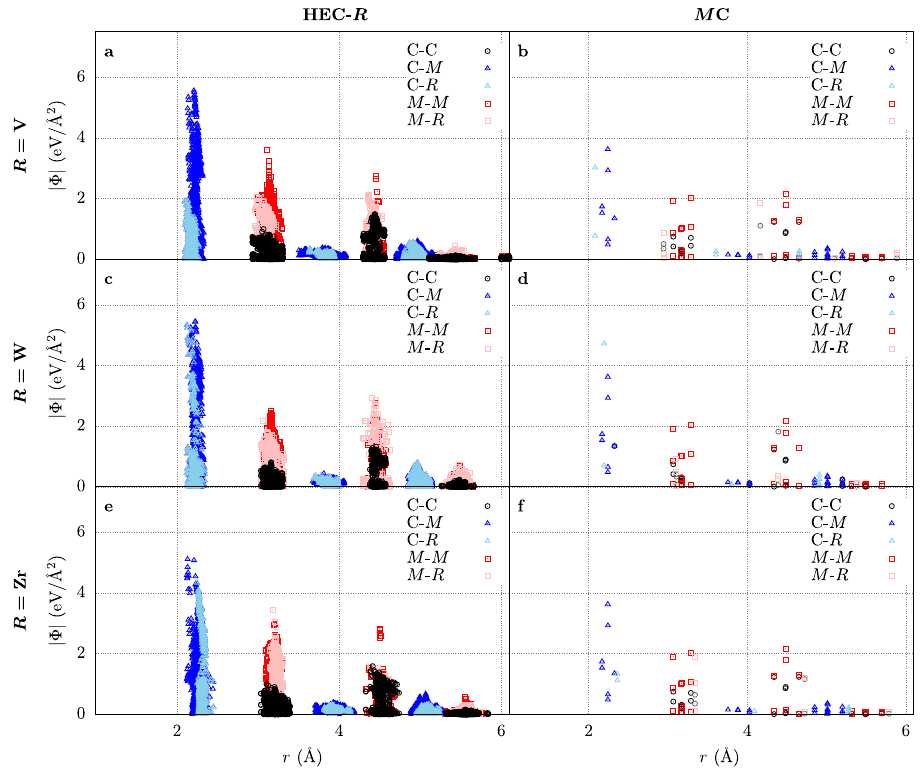
Fig. 3 Interatomic force constants. Force constants Φ for the high-entropy carbides HfNbTaTi R ð Þ C (HEC- R , left) and the rock-salt binary carbides M C (right): a , b HEC-V, c , d HEC-W, e , f HEC-Zr. Lighter colors represent IFCs containing R . IFCs were projected onto common Cartesian axes using AFLOW-XtalFinder 93 . the anion sublattice accommodating the different metal species. While the force constant patterns are similar between the HECs This leads to broken local symmetries, bonds of varying lengths, and the binaries, there is extensive smearing in the high-entropy and diversity of metal-metal interactions, all affecting the force material, especially in the fi rst coordination shell. The force fi eld in the high-entropy material. Figure 3 shows the effect of constants also show the origin of the frequency shifts for Zr and these disturbances on the high-symmetry rock-salt structure. V: nearest-neighbor force constants of V are signi fi cantly smaller